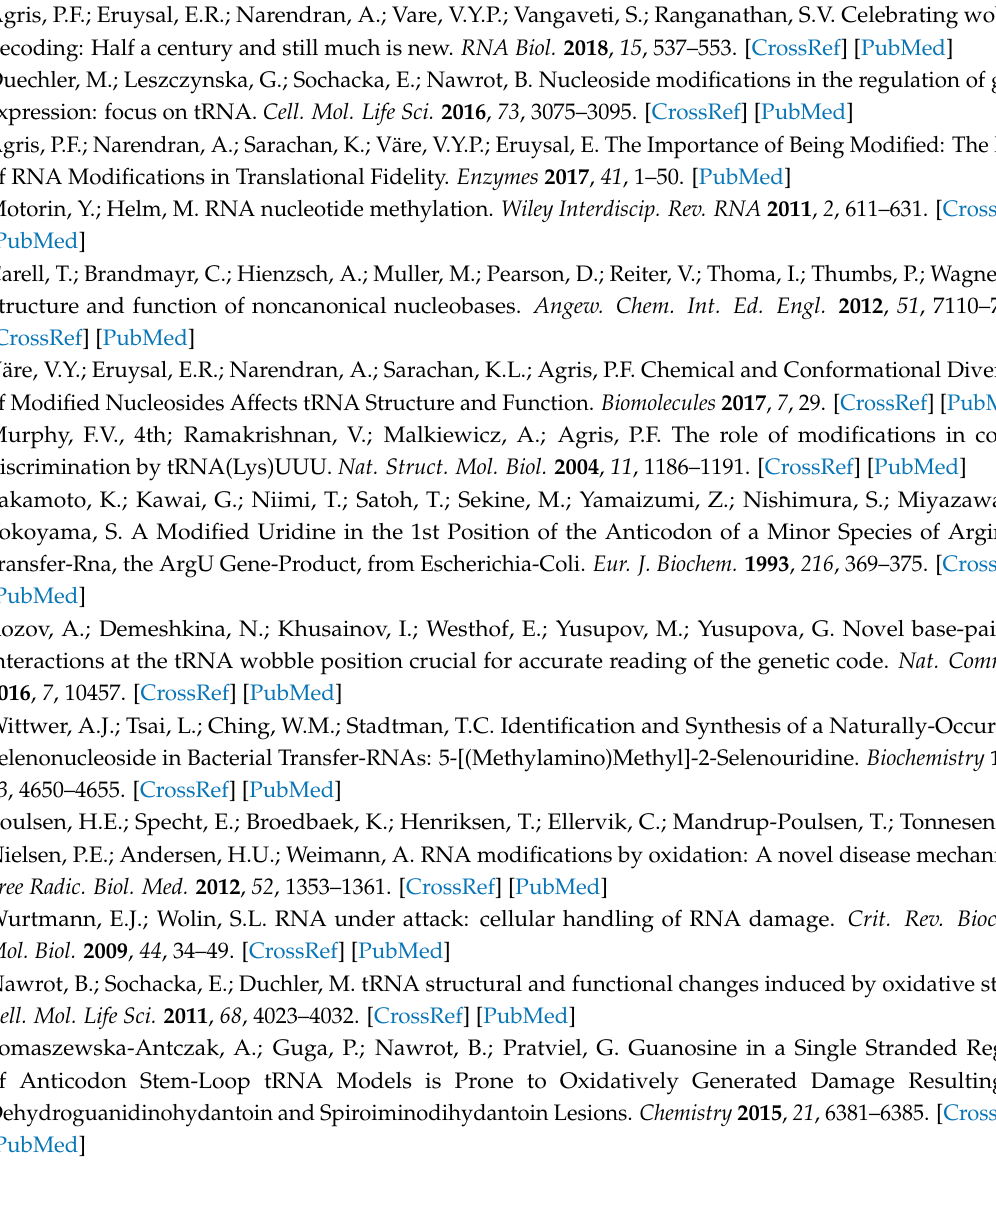
Figure S1: HR-ESI-MS analysis of 1, Figure S2: NMR analysis of 1: (A) HMBC, (B) NOESY, Figure S3: HR-ESI-MS analysis of 3 and 4, Figure S4: HR-MS analysis of 5 and 6, Figure S5: HR-MS analysis of 2 and its hydrolysis product 7, Figure S6: NMR analysis of 2 + 7: (A) HSQC, (B) HMBC, (C)